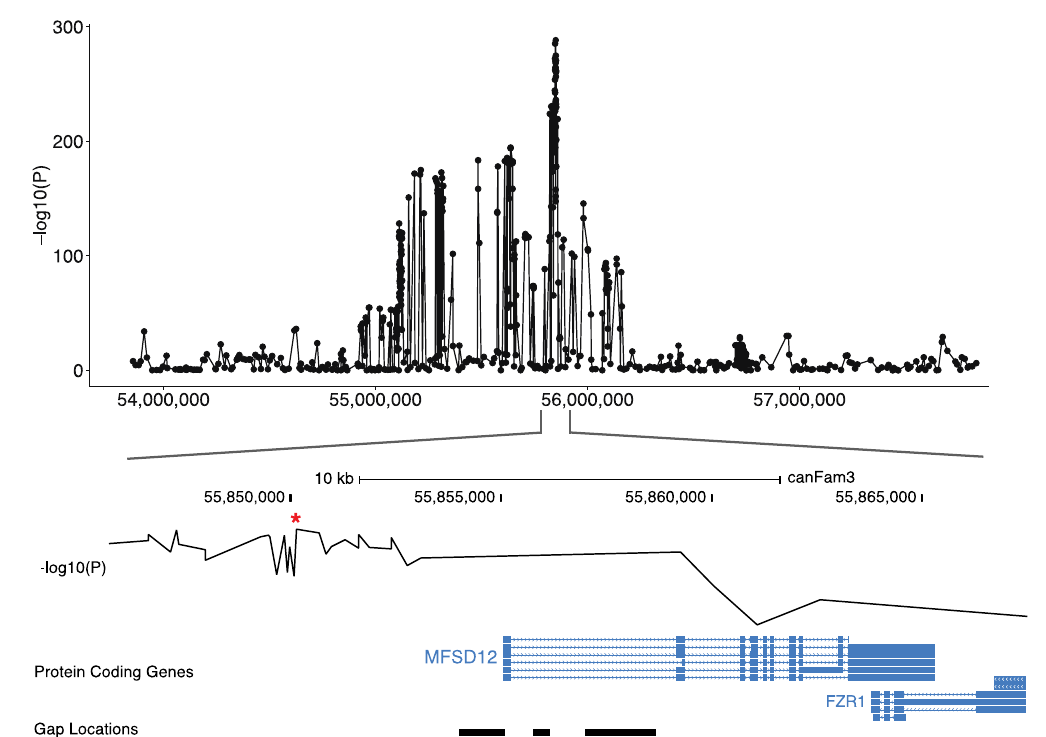
Figure 3. Screenshot of the locus on the canine chromosome 20 locus associated with the phaeomelanin dilution. The GWAS p-values of the 444 imputed variants on the 138 cases and 2325 controls are represented on the top. The best GWAS SNV (indicated by a *) located ~5 kb upstream of the MFSD12 gene is represented on the middle and the MFSD12 exon position, relatively to the gap position is illustrated on the bottom.